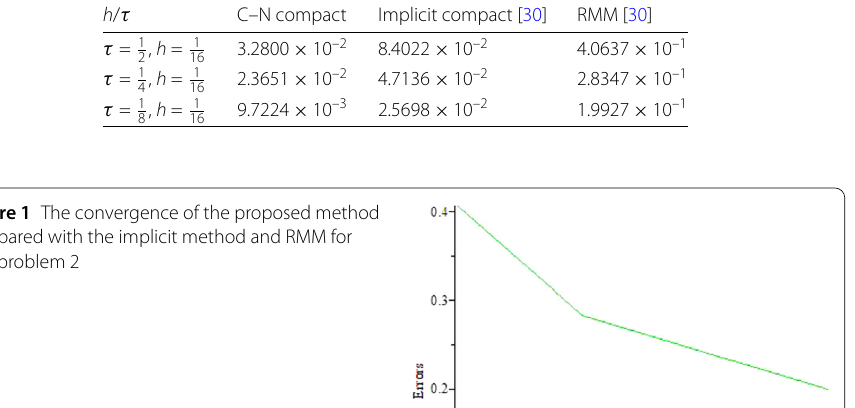
Table 7 Comparison between Proposed method when h = 1 radial basis functions method for Test problem 2